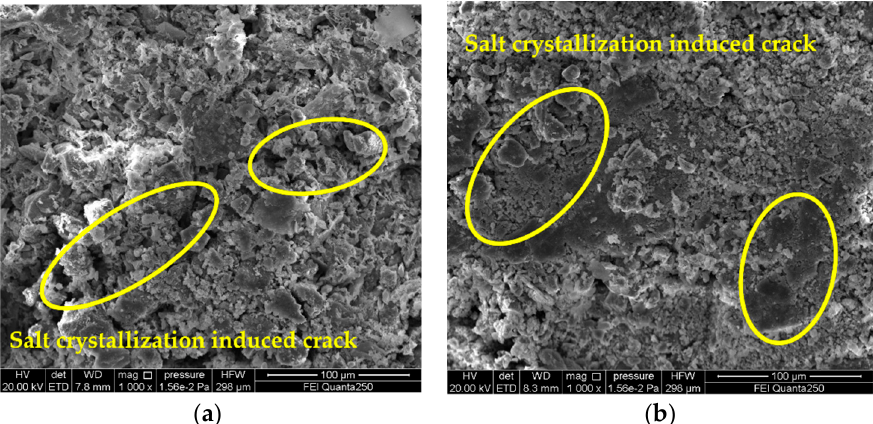
Figure 8. SEM image of gray brick sample of 3% calcium chloride (A 2 B 2 C 3 ) cycled 30 times. Detail of microcracks induced by calcium chloride salt crystallization (yellow circles). ( a ) inside the sample; ( b ) the surface of the sample.